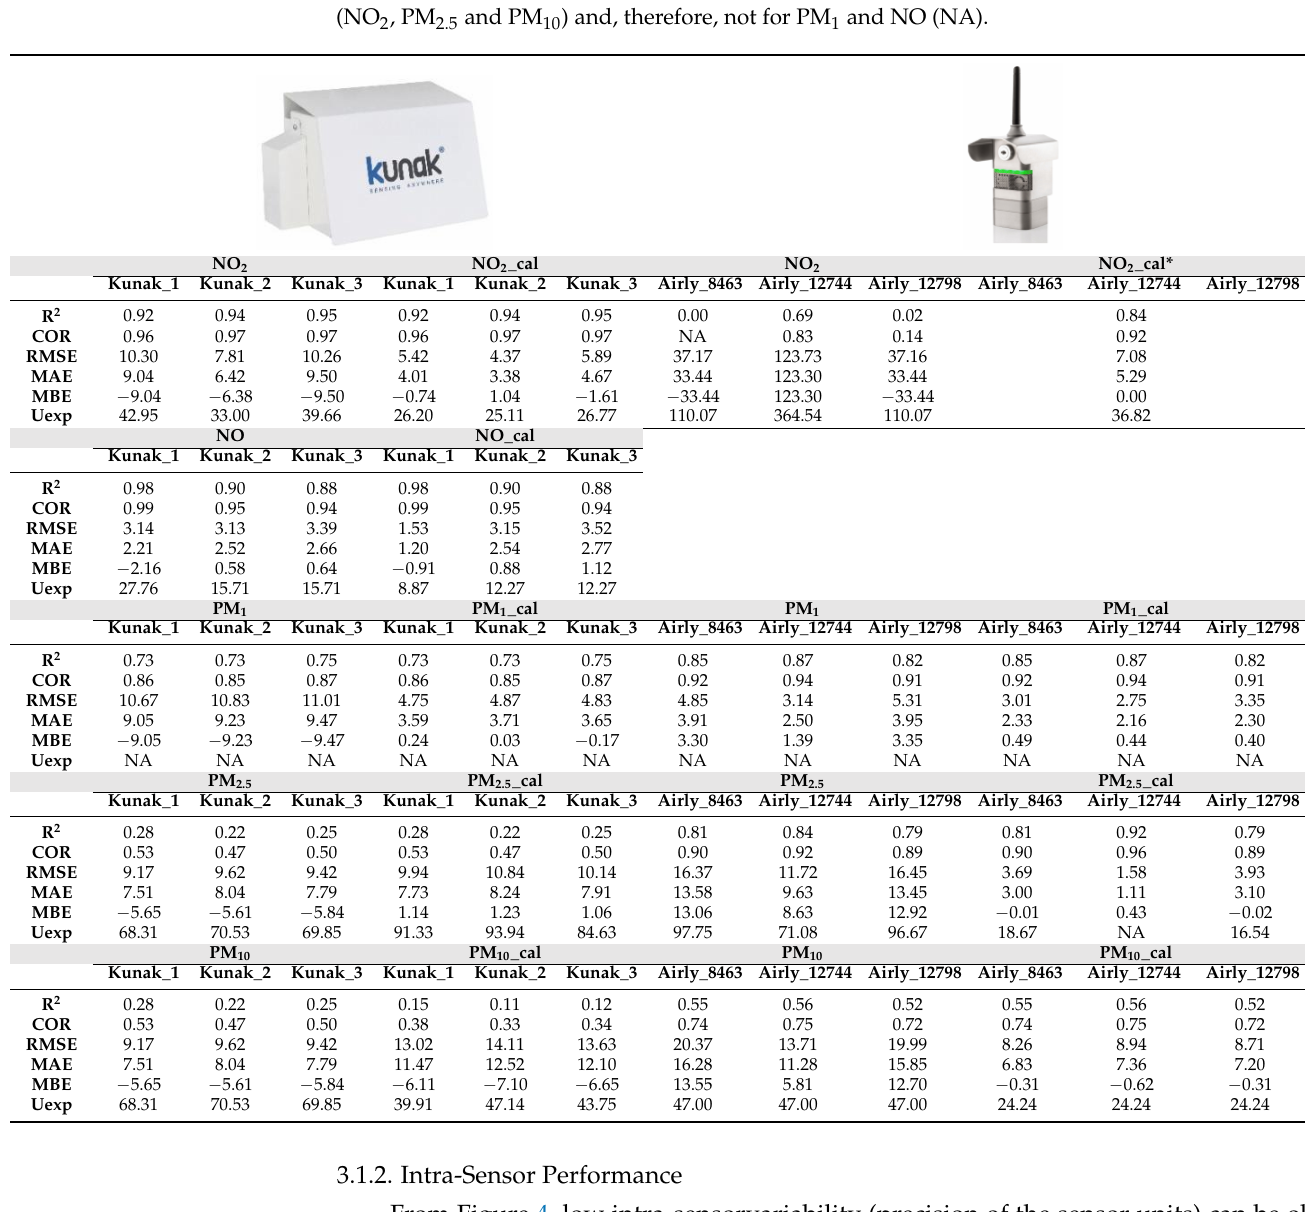
Table 2. Data quality metrics (R 2 , COR, RMSE, MAE, MBE, Uexp) calculated on the raw and locally re-calibrated (_cal) hourly-aggregated NO 2 , NO, PM 1 , PM 2.5 and PM 10 data for each of the sensor units (3 × Kunak and 3 × Airly). Local re-calibration is based on slope correction (sensor = a ∗